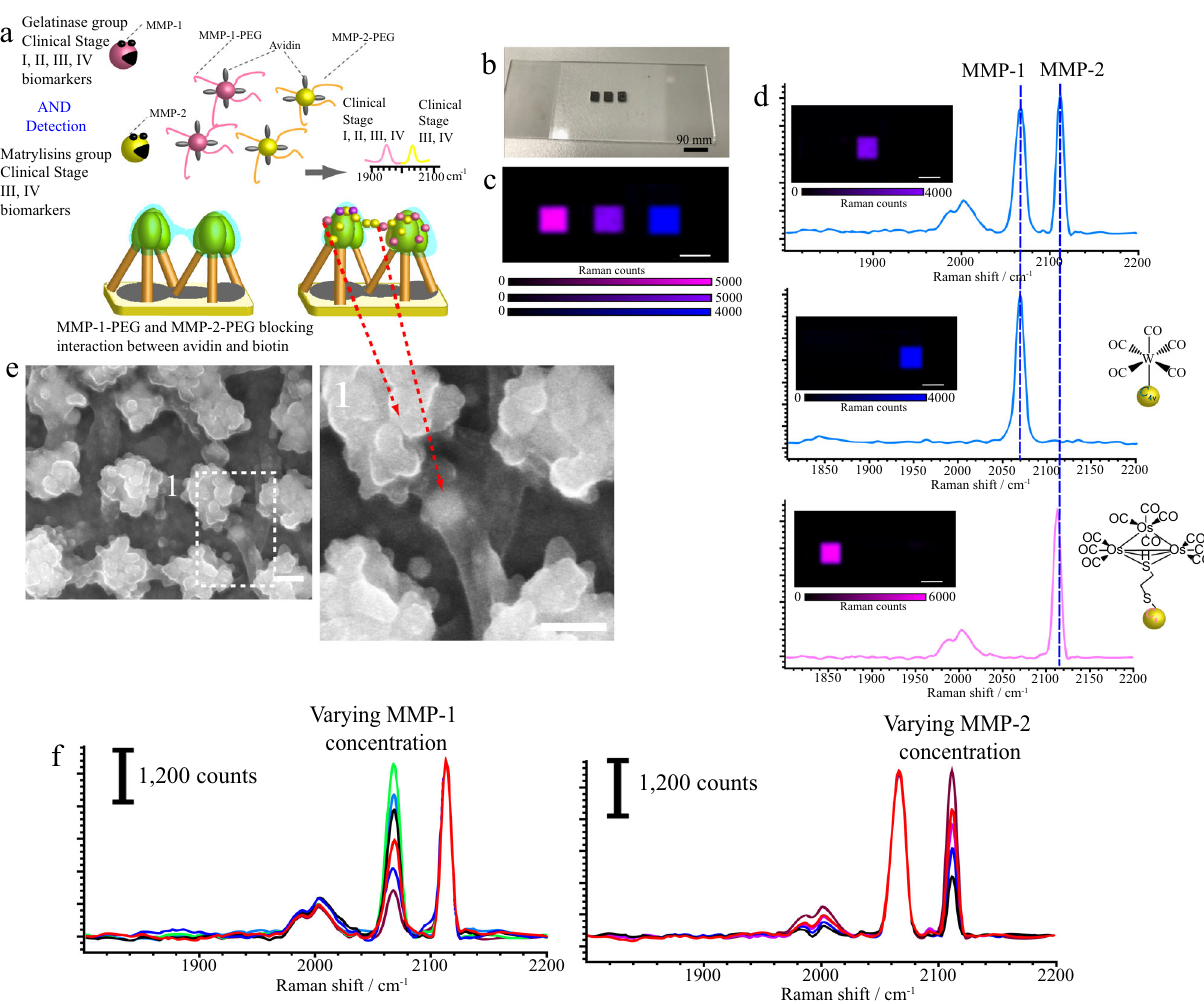
Fig. 5 Boolean logic AND detection. a Schematic representative of Boolean logic AND detection of MMP-2 and MMP-1. b Images of the nanogel substrate on a quartz slide. c SERS nanotags on a nanogel substrate spatially separated onto a piece of quartz slide. d Raman spectroscopy to unmix two colocalized symmetric bands of SERS nanotags on a nanogel substrate. The resulting images show the two SERS nanotags correctly separated into their corresponding spectral channels with minimal cross-talk between the spectra. e Trapping process of nanotags in nanogel as evidenced by SEM images. A representative image of three individual experiments is shown (scale bar: 100 nm). f Detection of various concentrations of MMP-1 (0.5 – 10 ng/mL) in the presence of 5 ng/mL MMP-2 and detection of MMP-2 (0.5 – 10 ng/mL) in the presence of 10 ng/mL MMP-1. Source data are provided as a Source Data fi (Supplementary Table 1). The selectivity of detection was evaluated in the presence of interfering substances, and the recovery range was found to be > 92% (MMP-1: 93% MMP-2: 95%; MMP-3: 93%; MMP-7: 95% and MMP-9: 92%). Thus,